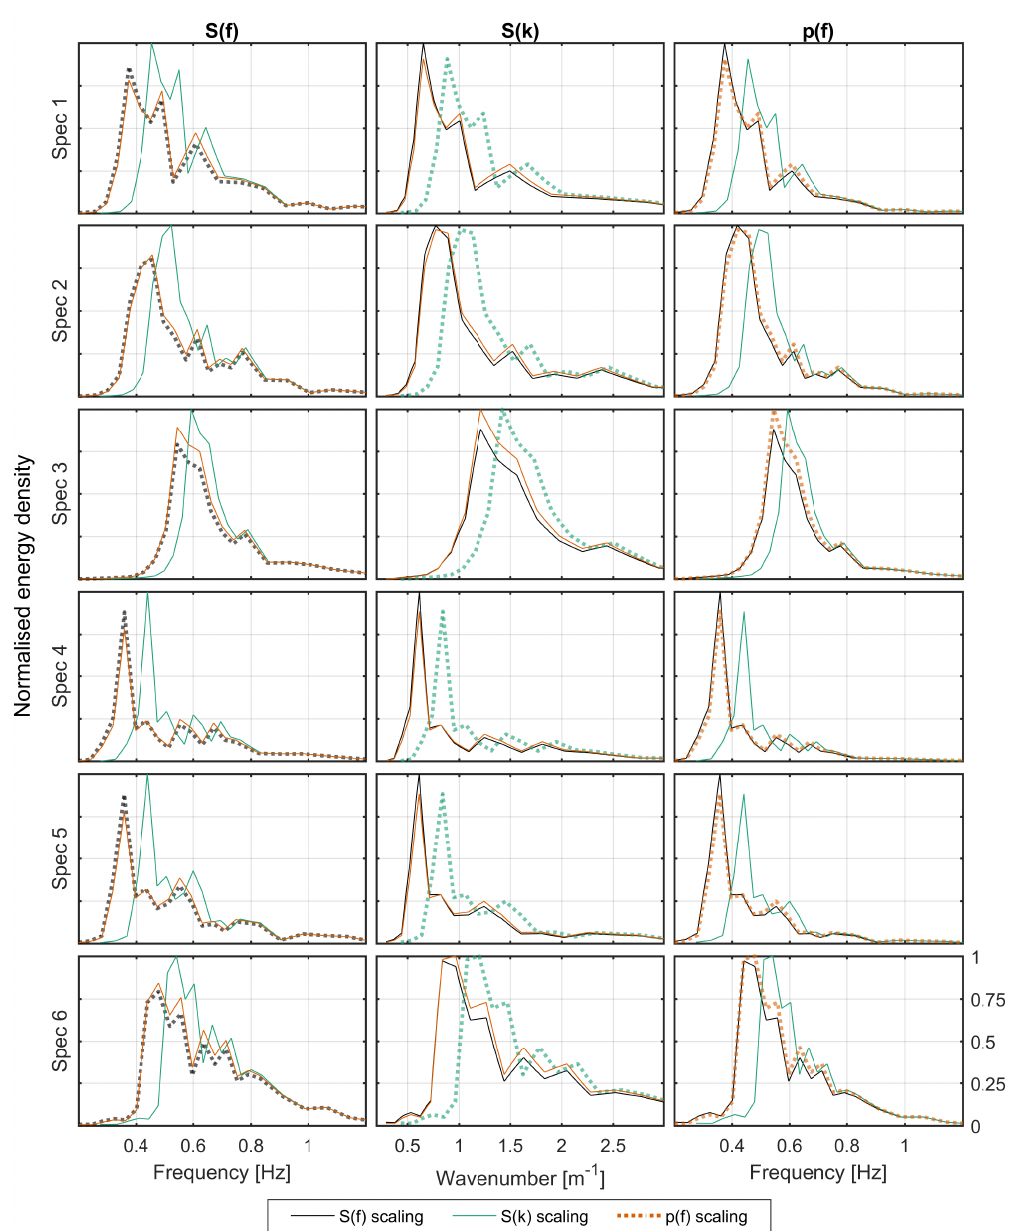
Figure A1. Resulting extreme spectra scaled in different ways. Shown is the resulting S ( f ) , p ( f ) and S ( k ) spectra when the S ( f ) , p ( f ) or S ( k ) spectrum is Froude scaled. The desired Froude scaled value is shown as a dashed line, and colours represent the different scaling